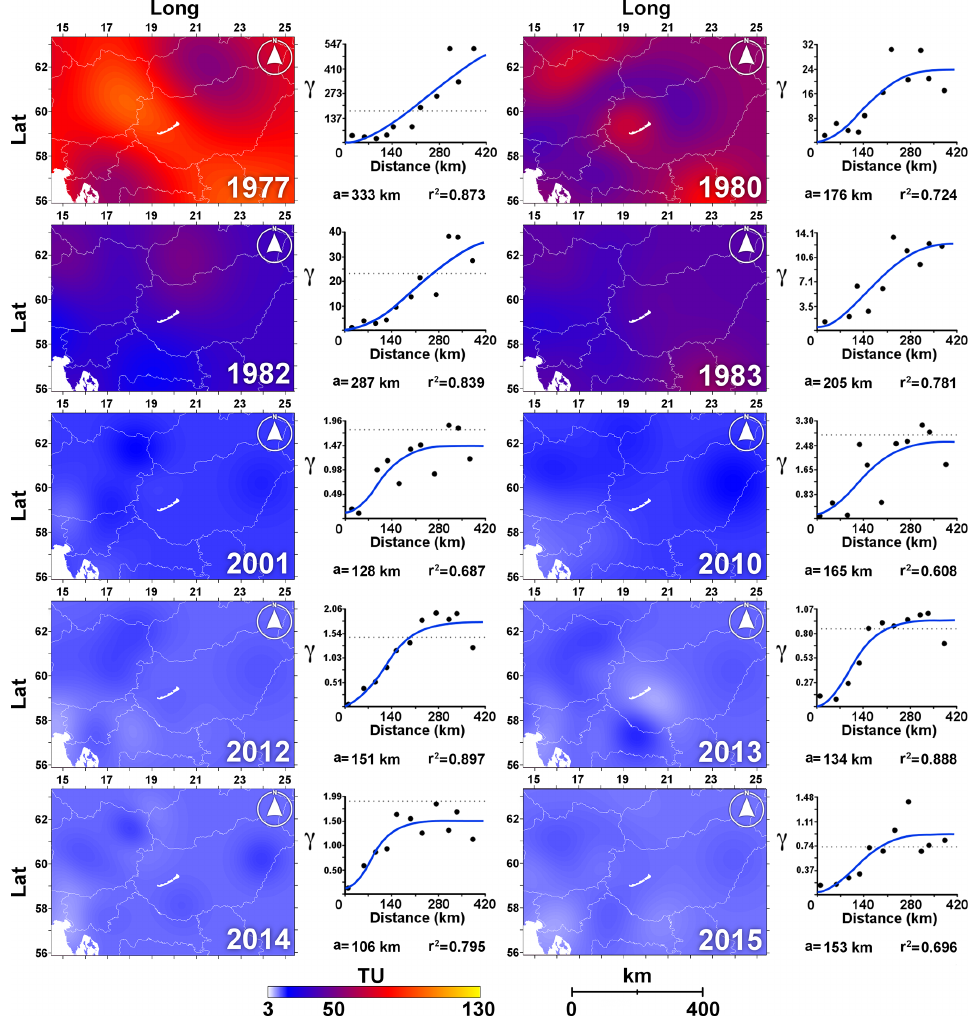
Figure 2. Isoscapes of amount-weighted annual mean 3 H activity (TU) in precipitation and semivariograms for the reference years in the Adriatic–Pannonian region. The Adriatic Sea and Lake Balaton are marked in white. Isoscape grid resolution: 1km × 1km. The figures on the right side of the isoscapes show the empirical (black dots) and theoretical (blue line) semivariograms used for kriging along with the obtained ranges (planar distances in kilometers) and the fit ( r 2 ) of the theoretical semivariograms. The dotted horizontal line indicates the average